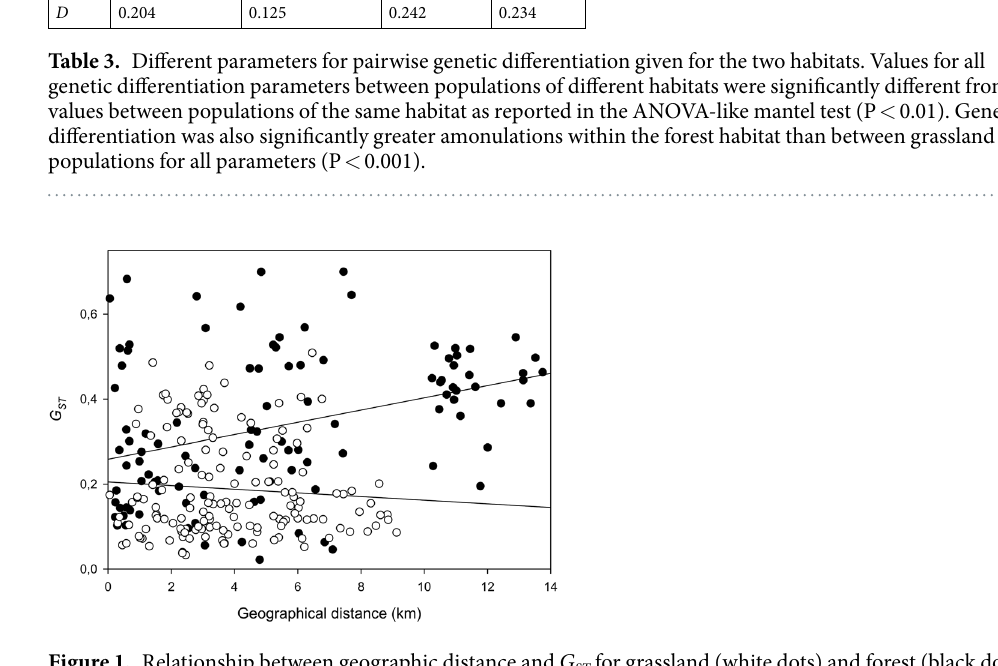
Figure 1. Relationship between geographic distance and G ST for grassland (white dots) and forest (black dots) populations.